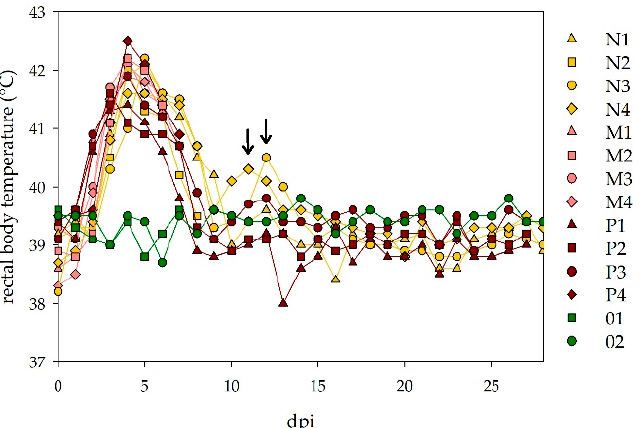
Figure 2. Rectal body temperatures of challenged sheep: all twelve infected sheep developed high fever following the NSDV inoculation, almost independent of the applied virus dosage. Two animals of the low dosage group (N3, N4) showed a second increase in their rectal body temperature (marked with arrows). The control animals did not develop an increase in their rectal body